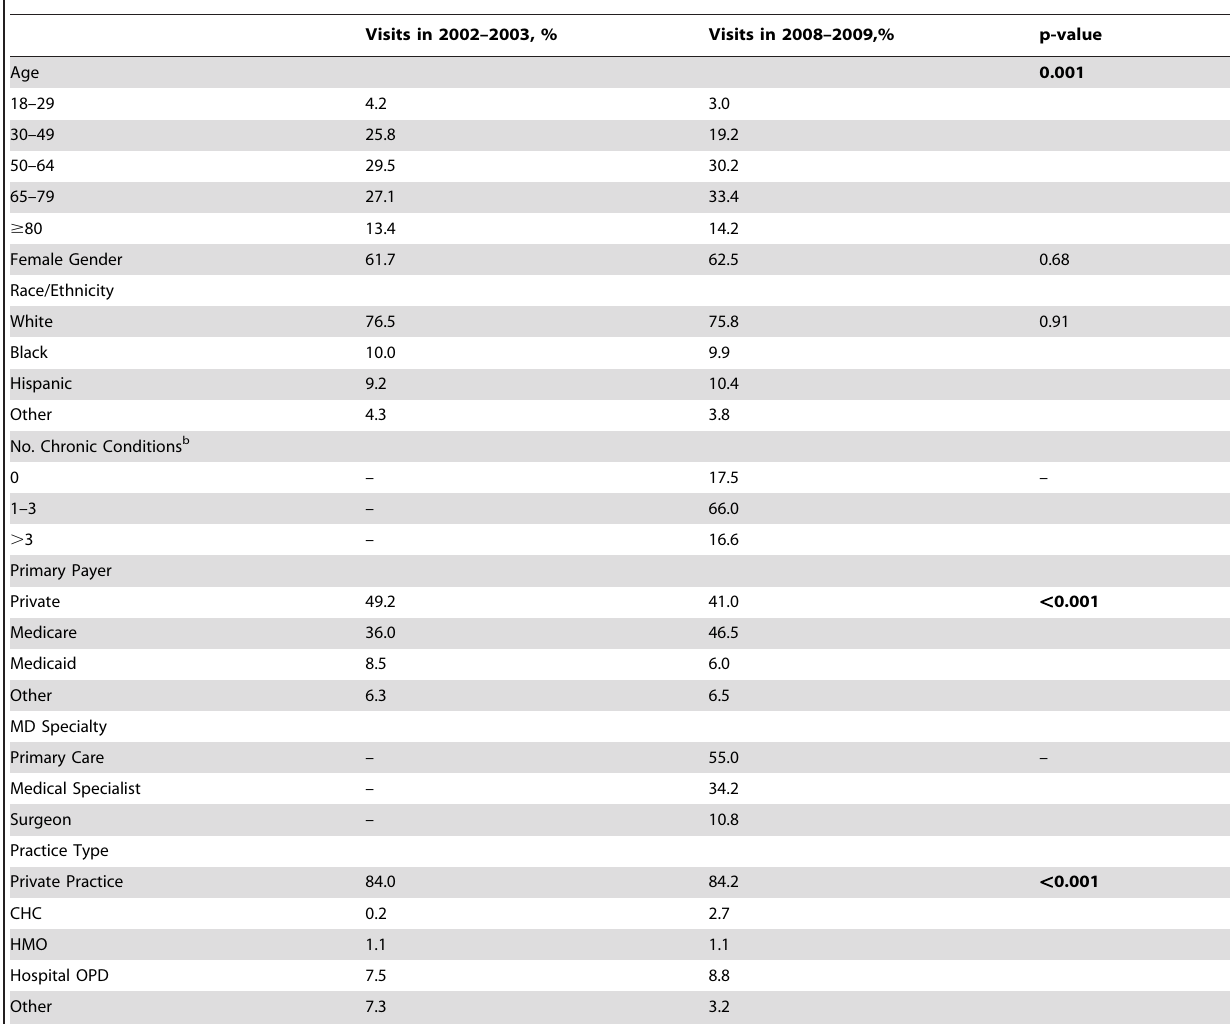
Table 2. Characteristics of visits, 2002–2003 and 2008–2009 a